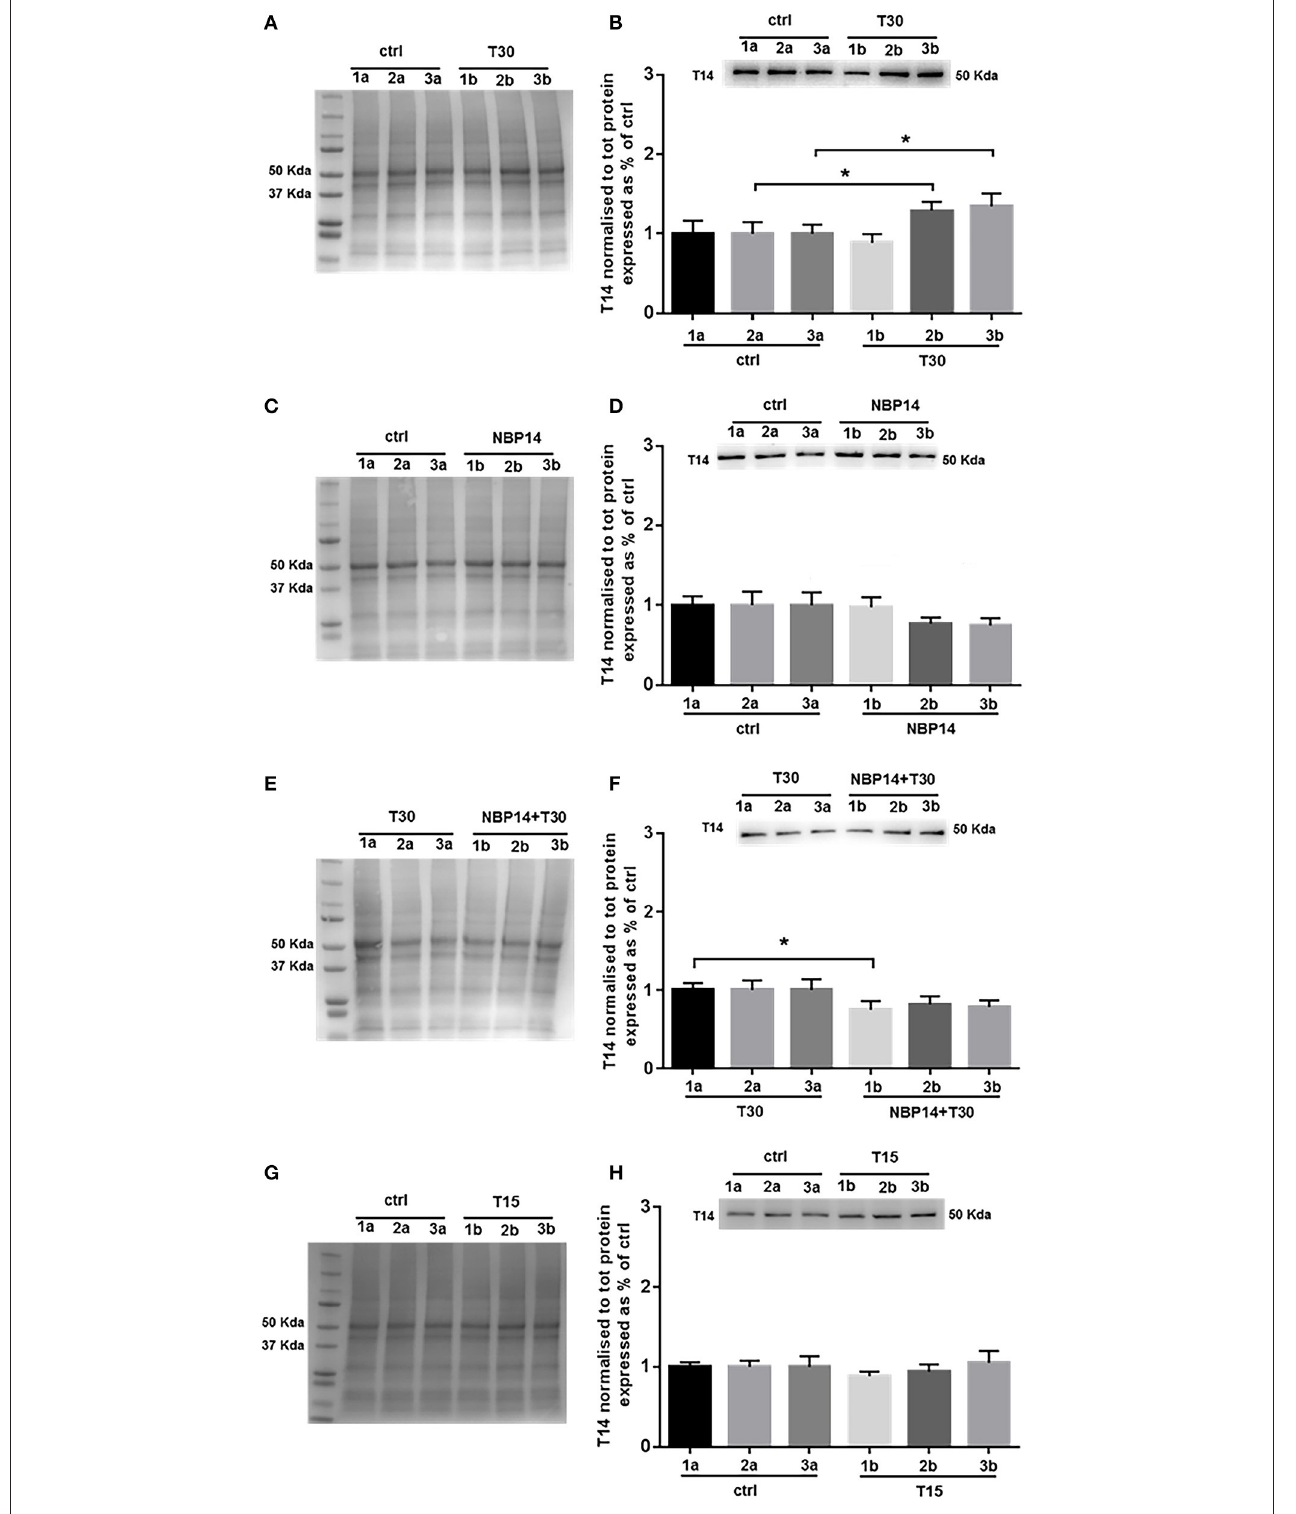
FIGURE 3 | Endogenous T14 is differently modulated by distinct treatments. (A,C,E,G) Representative total protein staining used as loading control. (B,D,F,H) Representative blots and bar graphs indicating T14 levels along the three BF subdivisions. (A) Total protein membrane subsequently immunoblotted for T14. (B) T30 exposure strongly affected the endogenous peptide expression across conditions and anatomical planes [ F (5, 55) = 4.669, p = 0.0013, two-way ANOVA].